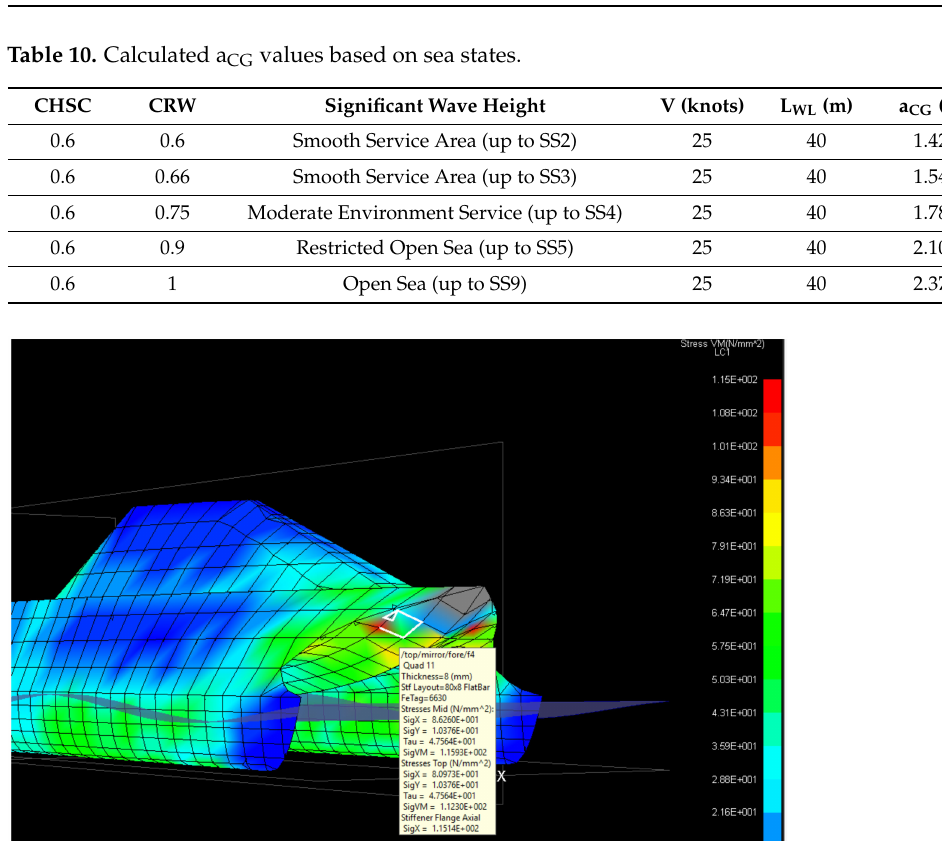
Figure 4. Stress values for LS1 loading